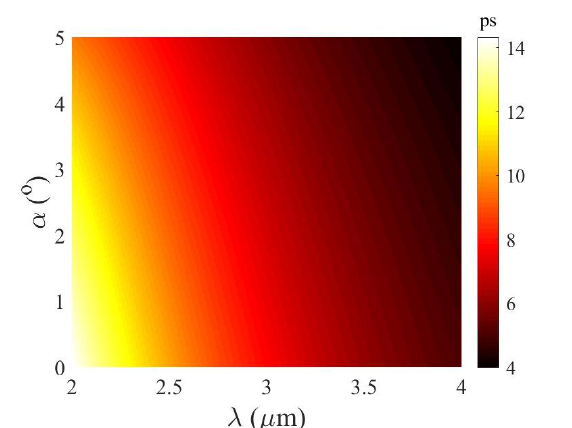
Figure 11. Temporal resolution of STEI system with varying light wavelength and propagation angle. The total propagation length is 15